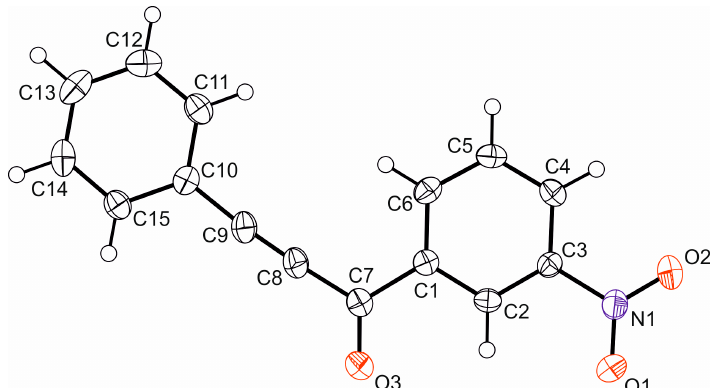
Figure 7. PLATON [34] plot of the molecular structure of 11af showing the atomic labels and displacement ellipsoids at 50% probability level. Selected distances and angles (in Å and deg): N1=O1 1.224(4), N1=O2 1.229(3), C3-N1 1.468(4), C7=O3 1.223(4), C1-C7 1.492(4), C7-C8 1.447(4), C8-C9